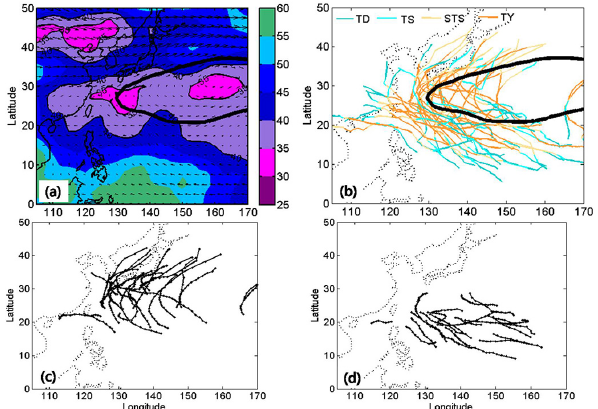
Figure 1. September 2004–2009 mean GFS-derived (a) 500– 400hPa layer RH (shading) and flow vectors, (b) geopotential height of 5880m at 500hPa (thick black line) which is also plot- ted in (a) and all tracks of TCs with colorized lines indicating storm intensity, (c) weakening cases and (d) strengthening cases during the 48h period used to classify them. Black contours are drawn at 40 and 35% RH in (a)